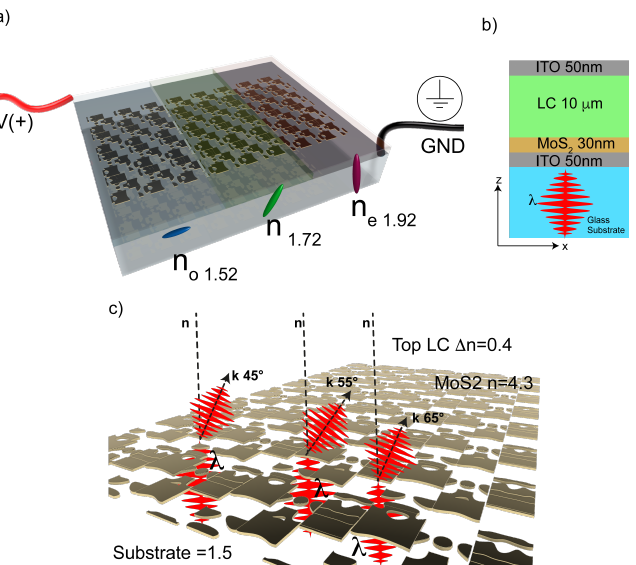
Figure 1. ( a ) Sketch of whole device composed of two ITO cover-slips containing the metastructures filled with the liquid crystal (LC). The ITO electrodes are connected to a FPGA processor that controls the applied voltage. ( b ) 2D Stack-up and relative thickness of each material. ( c ) A schematic view of the metasurfaces operation. The transmitted beam is deflected at the desired angle just by tuning the surrounding medium refractive